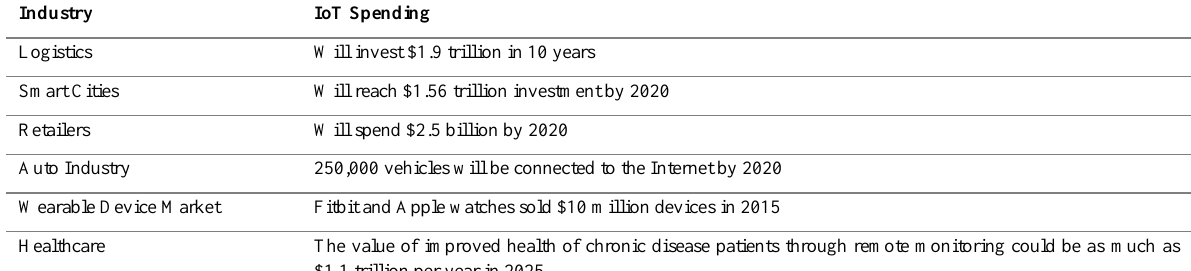
Table 1: IoT Spending In Different